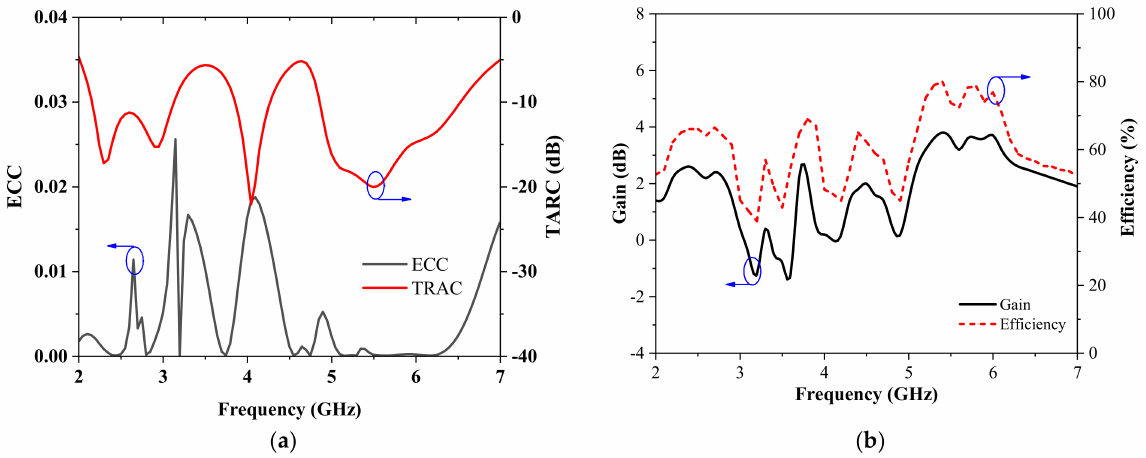
Figure 9. ( a ) Calculated ECC of the fabricated antenna and ( b ) measured peak gain and